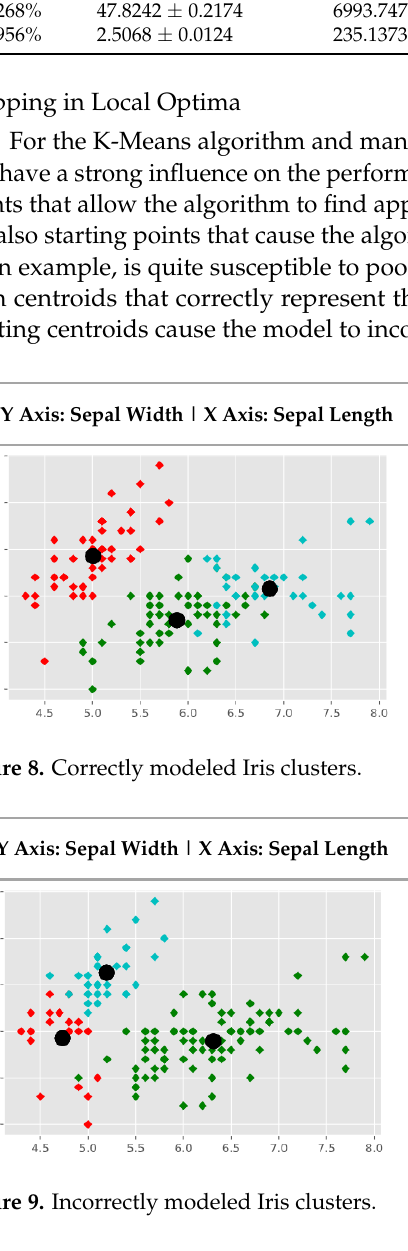
Table 3. Results from the K-Means Algorithm.